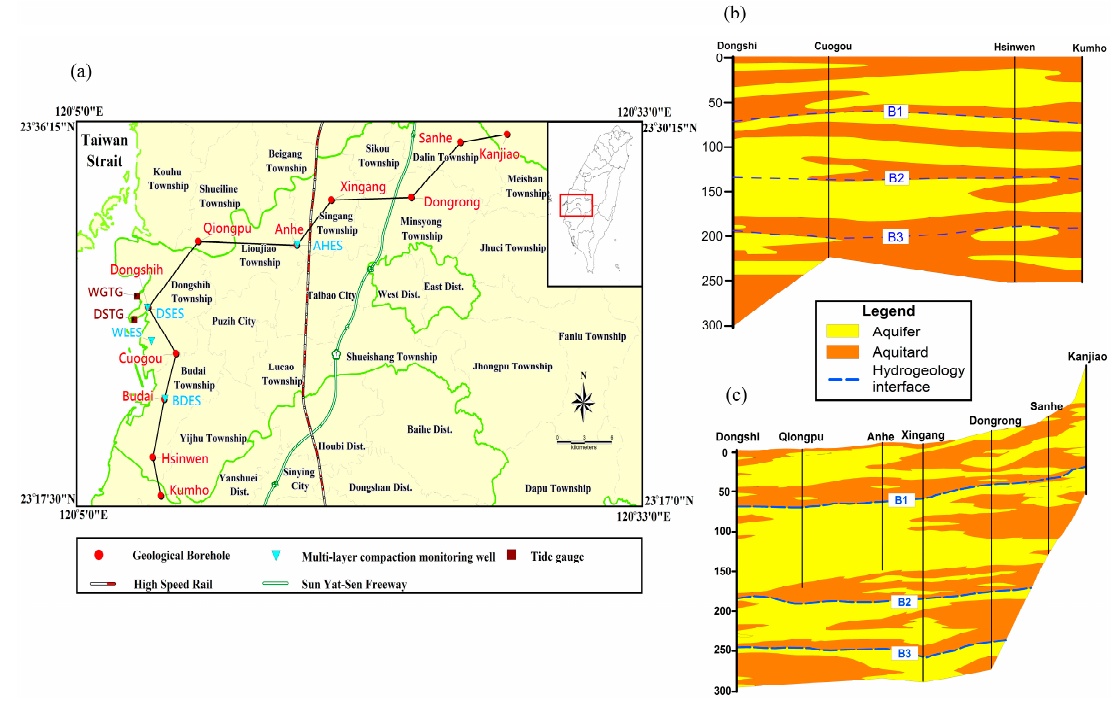
Figure 2. ( a ) The locations of the Dongshi-Kumho profile (coastal, north-south lying) and the Dongshi-Kanjiao profile (coast-to-inland, west-east lying) in Chiayi, with drilling sites (boreholes), MLCWs and tide gauges. The hydrogeological settings along ( b ) the Dongshi-Kumho profile, and ( c ) the Dongshi-Kanjiao.